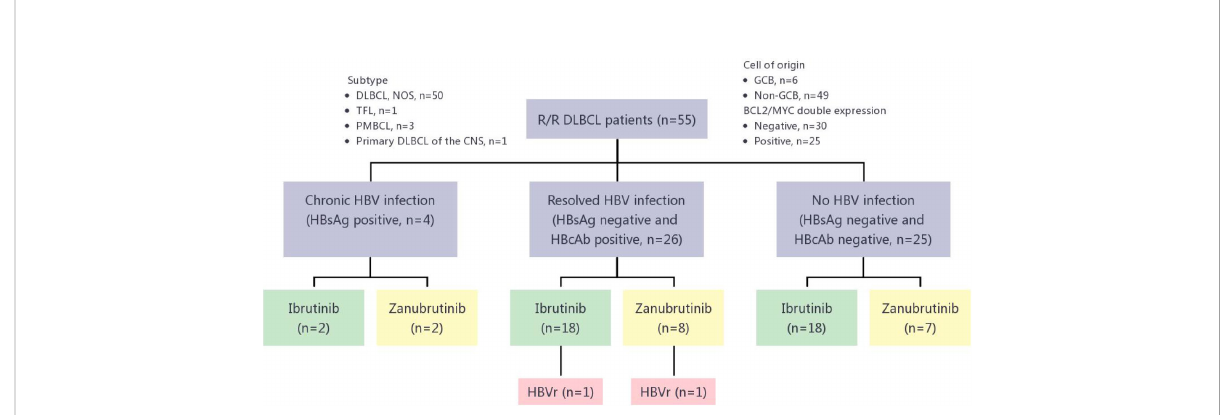
FIGURE 1 HBVr in R/R DLBCL patients treated with different BTKis. R/R DLBCL, relapsed or refractory diffuse large B-cell lymphoma; DLBCL, NOS, diffuse large B-cell lymphoma, not otherwise speci fi ed; TFL, transformed follicular lymphoma; PMBCL, primary mediastinal large B-cell lymphoma; CNS, central nervous system; GCB, germinal center B-cell – like; HBV, hepatitis B virus; HbsAg, hepatitis B surface antigen; HbcAg, hepatitis B core antibody; HBVr, hepatitis B virus reactivation; BTKis, Bruton tyrosine kinase